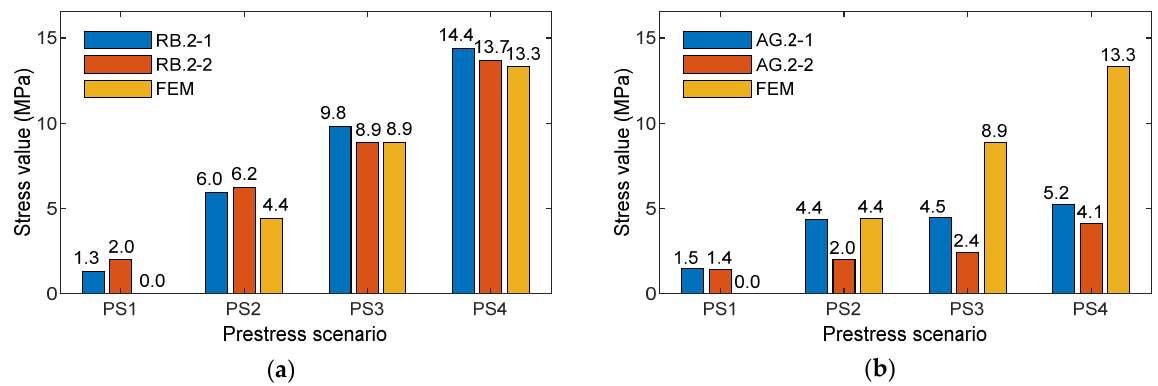
Figure 27. Comparison of stress results between experimental prediction using empirical equation versus numerical simulation of 9-strand anchorage: ( a ) Smart rebar; ( b ) Smart aggregate.